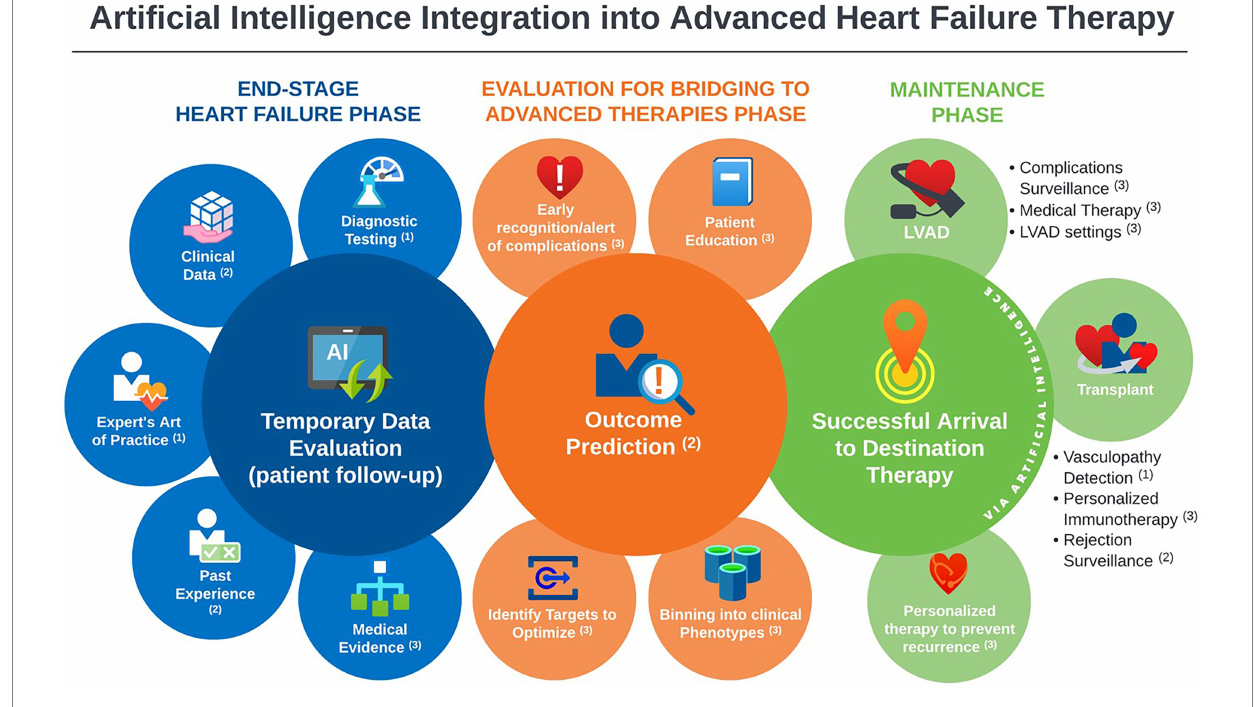
FIGURE 2 Landscape overview of artificial intelligence applications in advanced heart failure practice, with annotations indicative the level of maturity of the available literature of each application; 1 Promising, but not yet mature for clinical use. 2 Good support, ready for prospective testing. 3 Theoretical potential, but no/negligible